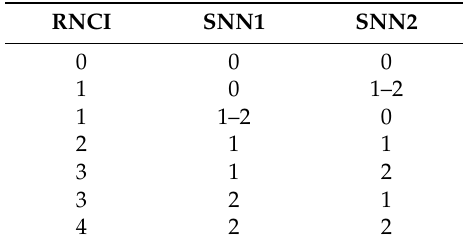
Table 4. Rain/no-rain classification index (RNCI) values corresponding to the NN outputs. RNCI SNN1